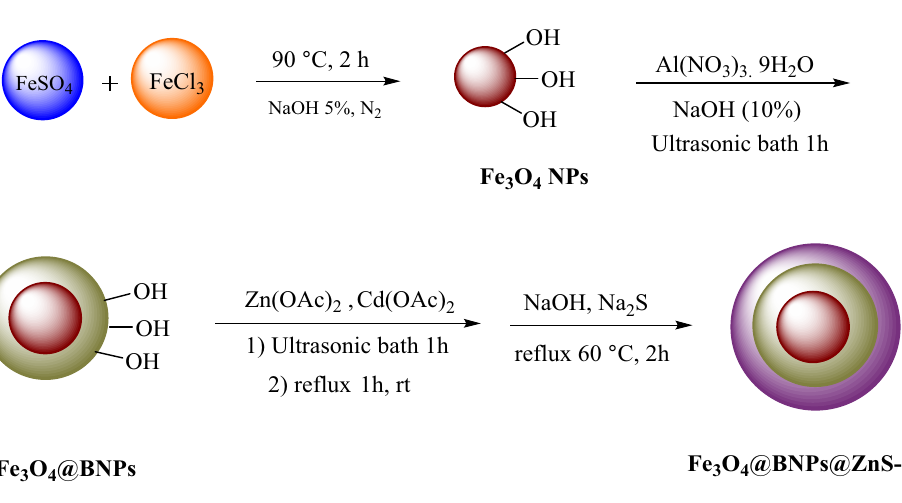
Figure 1. Photocatalyst synthesis